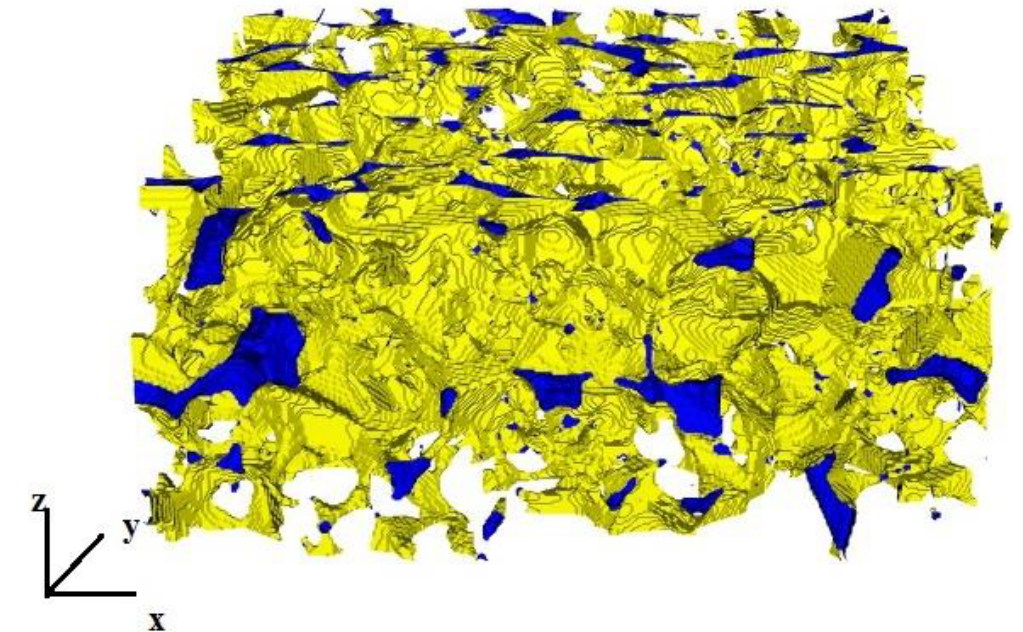
Figure 2. The view from side of the stereolithography surfaces of the S1 image, measuring 868.3 micrometers in each direction